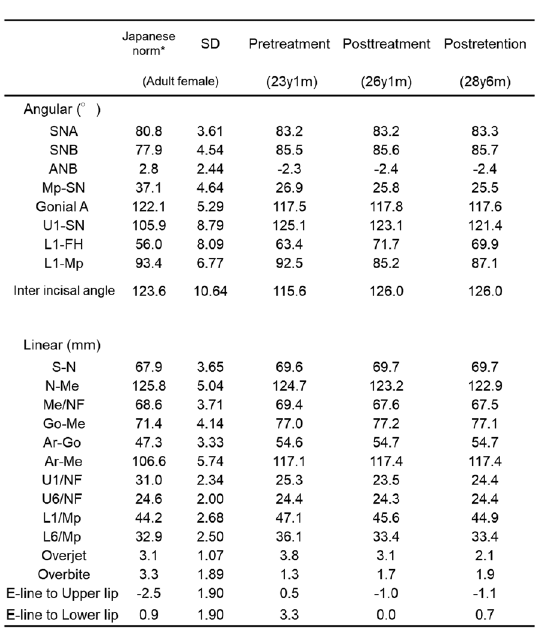
Table I. Cephalometric